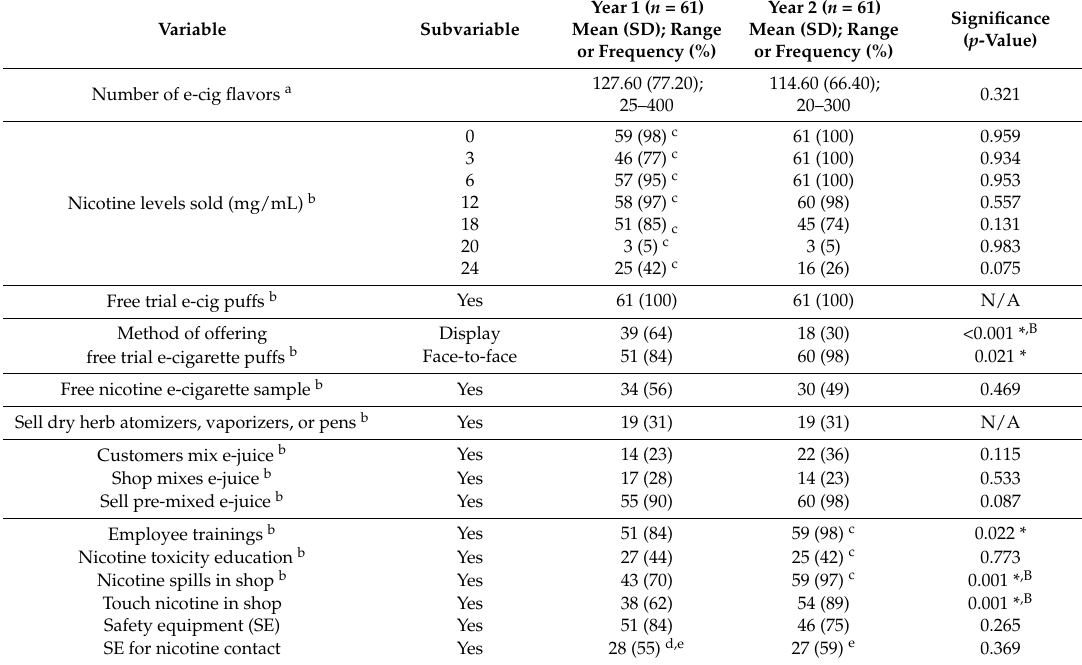
Table 2. Vape shop characteristics ( n = 61) using t -test or simple logistic regression.